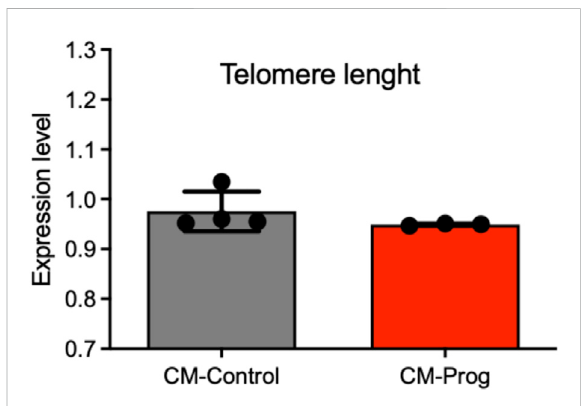
FIGURE 7 Telomere length in iPSC-derived cardiomyocytes. Telomere Length analysis in iPSC-derived cardiomyocytes performed by qPCR from distinct cellular differentiations. Columns represent mean values and bars SEM, and non-parametric Mann- Whitney test was applied (CM-Control n = 4; CM-Prog n =